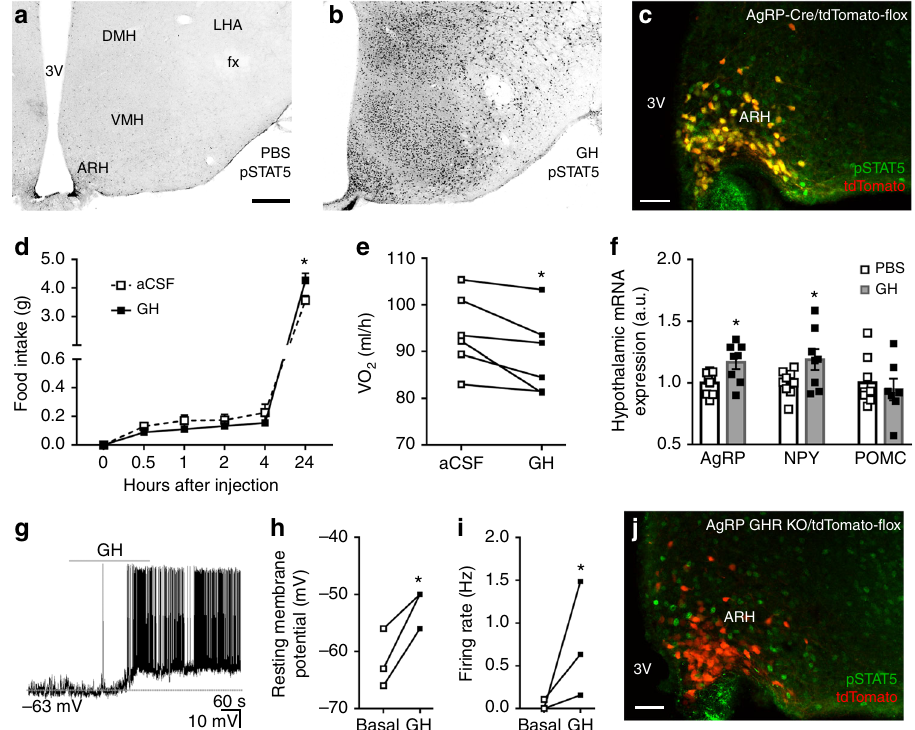
Fig. 1 Orexigenic effect of growth hormone (GH) via activation of agouti-related protein (AgRP) neurons. a , b Photomicrographs showing the hypothalamic distribution of signal transducer and activator of transcription 5 (STAT5) phosphorylation (pSTAT5) 90 min after an intraperitoneal (i.p.) injection of phosphate-buffered saline (PBS) or porcine GH (20 µ g/g body weight (b.w.)). 3V third ventricle, ARH arcuate nucleus, DMH dorsomedial nucleus, fx fornix, LHA lateral hypothalamic area, VMH ventromedial nucleus. Scale Bar = 200 µ m. c More than 90% of AgRP neurons (red) in the ARH are responsive to porcine GH as indicated by the co-expression of pSTAT5 (green). Yellow represents double-labeled cells. Scale Bar = 50 µ m. d Intracerebroventricular (i.c.v.) infusion of porcine GH (6 µ g in 2 µ L) increased food intake (0.5 h: t (8) = 1.258, P = 0.244; 1 h: t (8) = 2.075, P = 0.0717; 2 h: t = 1.425, P = 0.1919; 4 h: t = 1.518, P = 0.1675; 24 h: t = 2.801, P = 0.0232; n = 9), compared to the infusion of arti fi cial cerebrospinal fl uid (aCSF). (8) (8) (8) e The i.c.v. infusion of porcine GH reduced energy expenditure ( t (5) = 3.193, P = 0.0242, n = 6; paired t- test) of C57BL/6 mice. f Hypothalamic gene expression in C57BL/6 mice that received i.p. infusion of either PBS or porcine GH (AgRP: t (15) = 2.723, P = 0.0157; neuropeptide Y (NPY): t (15) = 2.144, P = 0.0488; proopiomelanocortin (POMC): t = 0.5188, P = 0.612; n = 9; unpaired t -test). g Representative whole-cell patch-clamp recording of a GH (14) responsive AgRP neuron. Dashed line indicates the resting membrane potential. Porcine GH (5 µ g/mL) was applied to the bath for approximately 5 min. h , i Increased resting membrane potential ( t (2) = 4.768, P = 0.0413; paired t -test) and fi ring rate ( t (2) = 3.001, P = 0.0477; paired t- test) of GH-responsive AgRP neurons ( n = 3). j AgRP growth hormone receptor knockout (GHR KO) mice showed very few GH-induced pSTAT5 (green) in AgRP neurons (red). Scale Bar = 50 µ m. All results were expressed as mean ± s.e.m. * P <